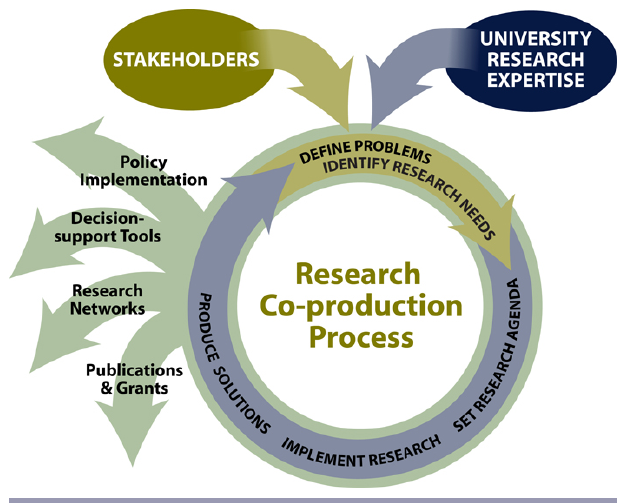
Fig. 1 . The Mitchell Center's research co-production